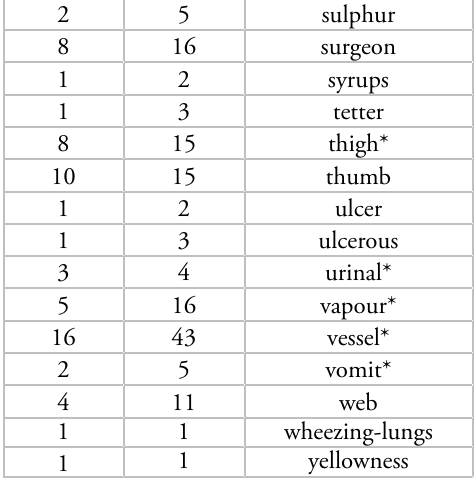
Table 4: Frequency comparison of medical terms (from Lists C and B).